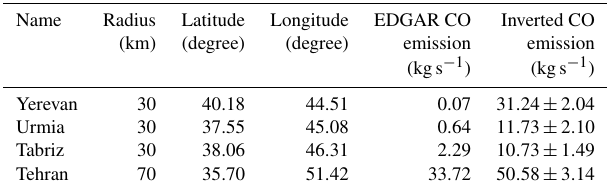
Table 1. CO emissions extracted from the EDGAR inventory in a radius around the indicated cities and inverted from the TROPOMI CO retrievals shown in Fig. 3. on 18 December